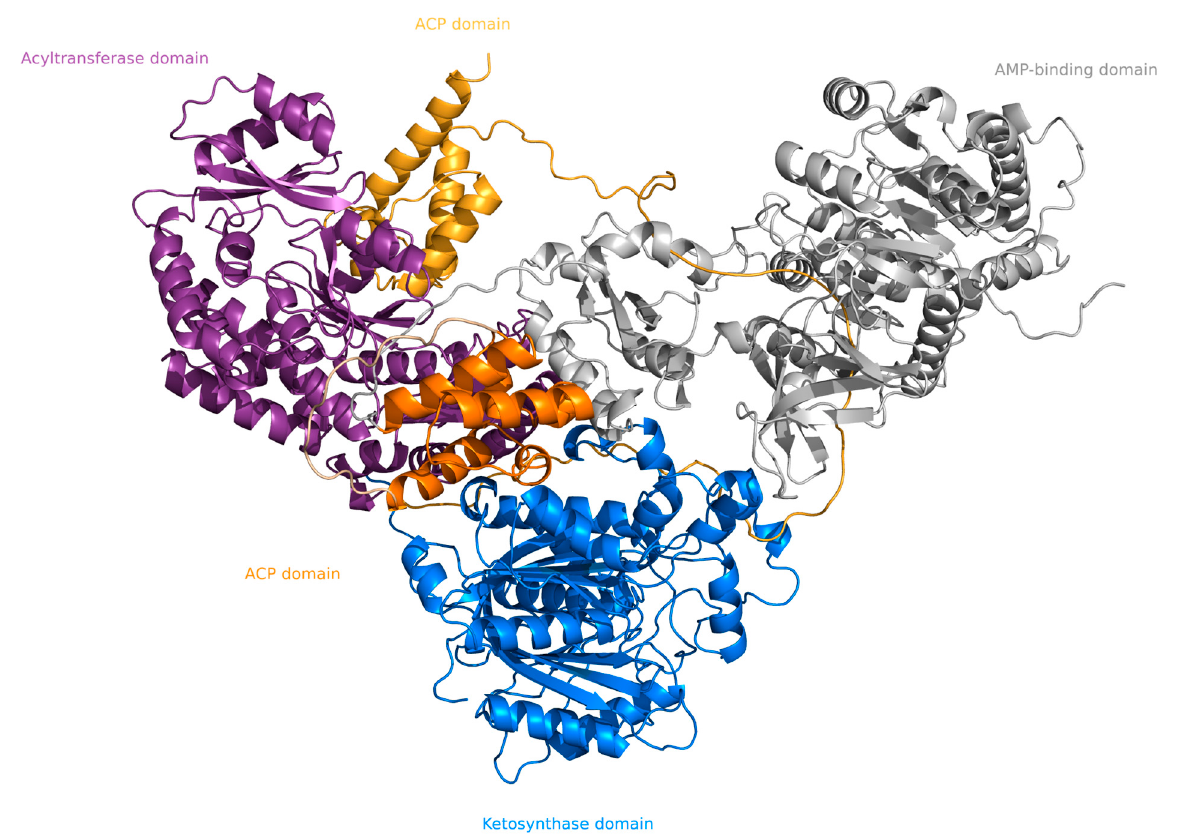
Figure 2. nnHispS protein structure, predicted by AlphaFold 2.0 [10].